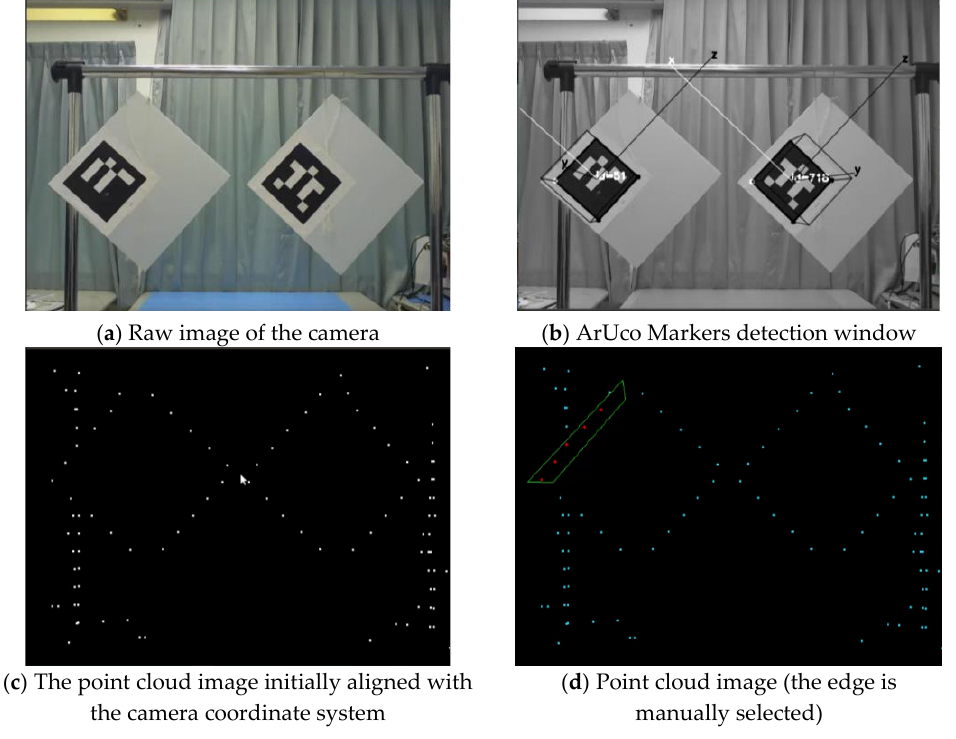
Figure 11. Four windows during joint calibration.